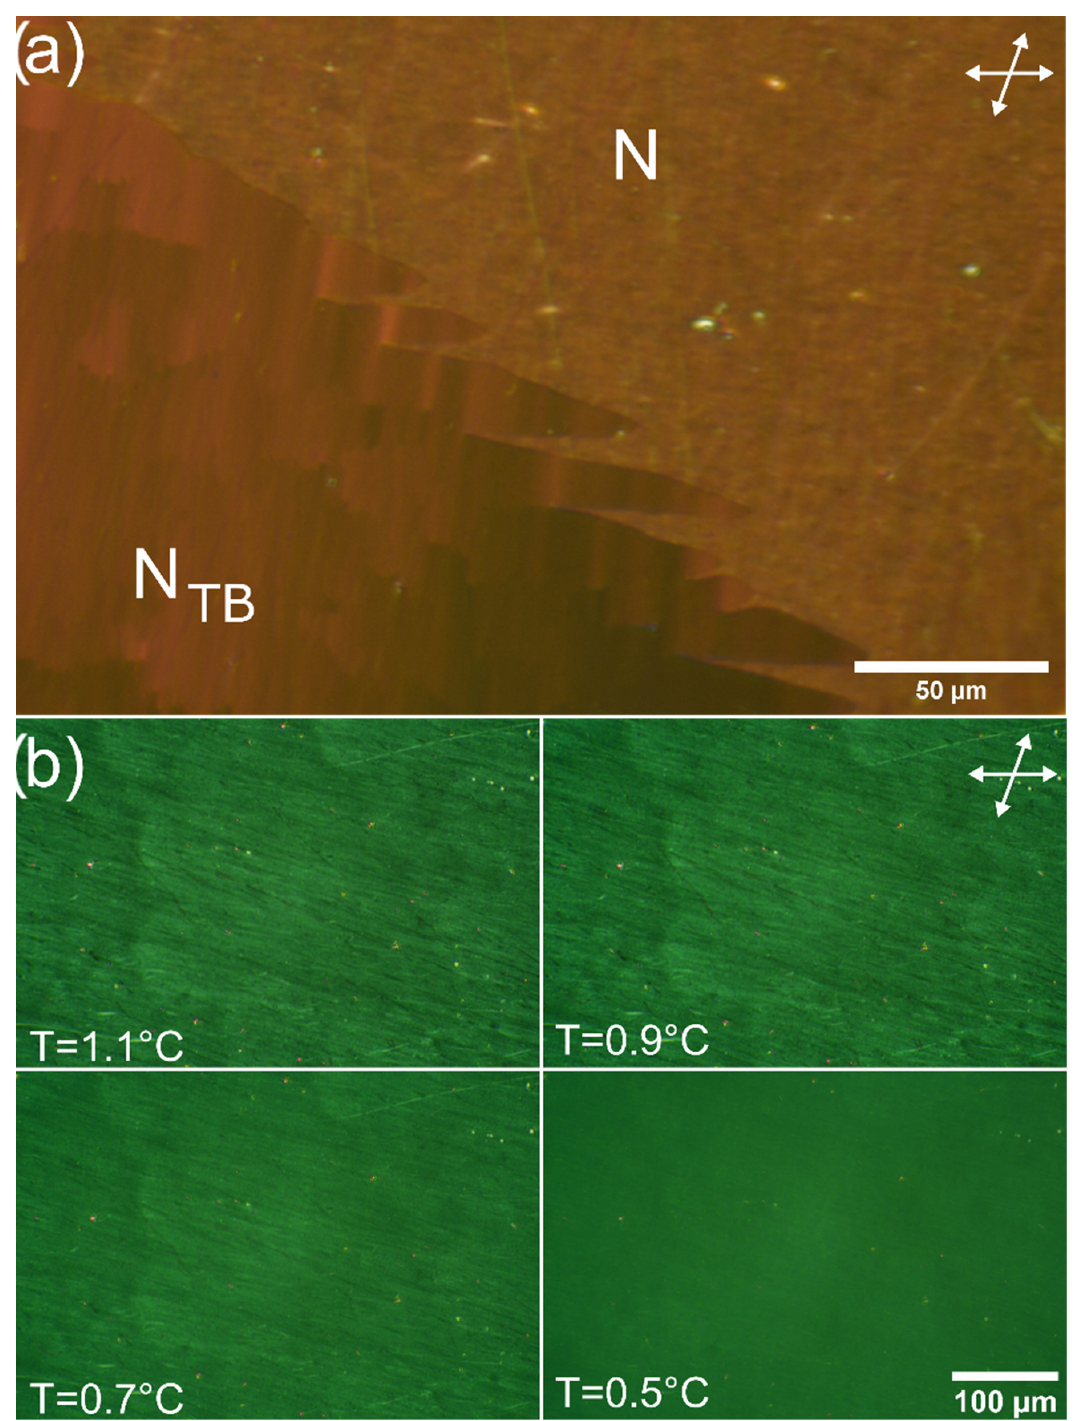
Figure 4. Polarized optical micrographs of the 8CB/CB7CB binary system during the N/N TB phase transitions at two different concentrations. ( a ) 𝜙 = 55 wt%: a front interface between the two phases is easily observed at T = 37 °C. ( b ) 𝜙 = 30 wt%: the phase transition is characterized by a gradual change of contrast (over ~0.5 °C) but without any front interface. Slightly uncrossed polarizers. As with 5CB [17,18], the addition of 8CB to CB7CB induced a decrease of both Iso/N and N/N TB phase transitions temperatures. It should be noted that adding CB7CB to 8CB also decreased the N/SmA transition temperature but concomitantly increased the Iso/N transition temperature, which